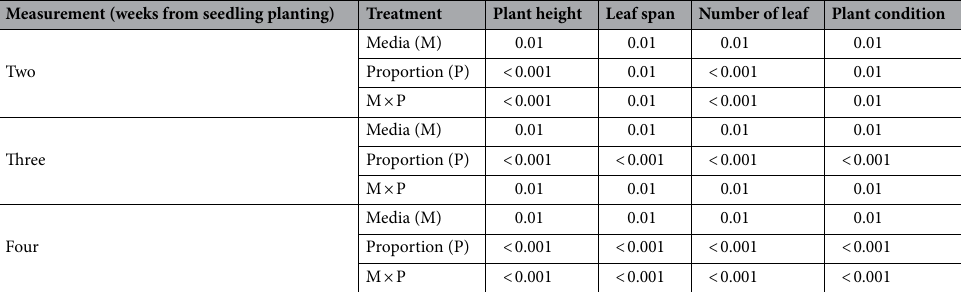
Measurement (weeks from seedling